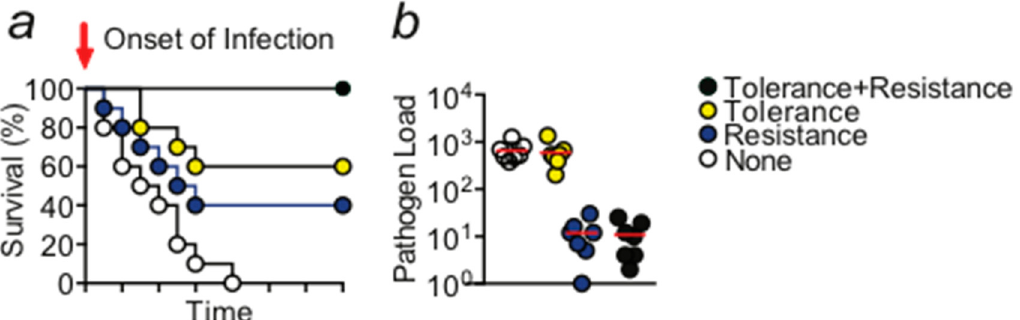
Figure 1. ( a ) Schematic Kaplan–Meier survival plot illustrating the protective effect exerted by disease tolerance and resistance mechanisms. Activity of both mechanisms is required in order to obtain the optimal level of protection. ( b ) Schematic display of the pathogen load of any given organ, animal, or species. A gene that provides disease tolerance to infection acts independently of the pathogen load while a gene that provides resistance acts via reducing the number of pathogens. Circles would indicate individual samples.